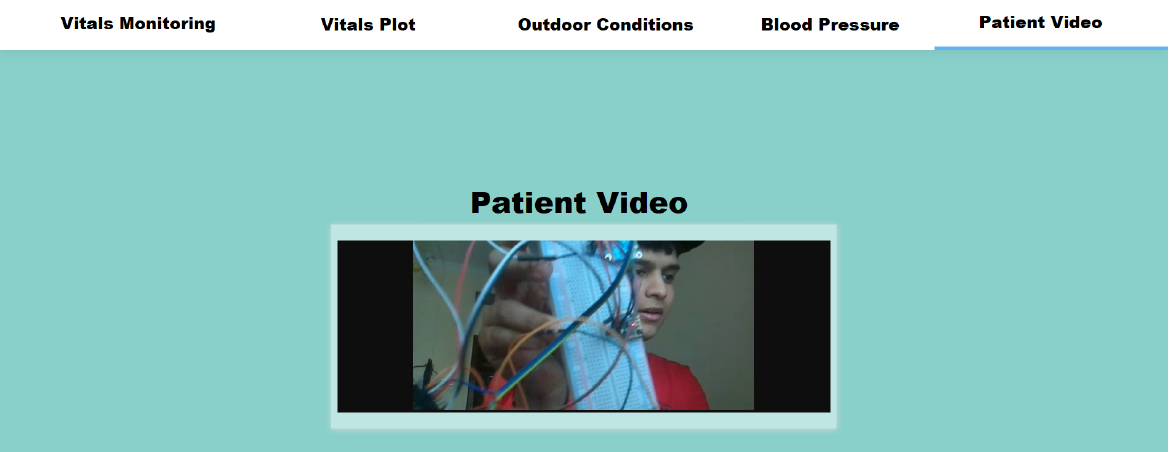
Figure 11. Live feed of the patient displayed on the website.